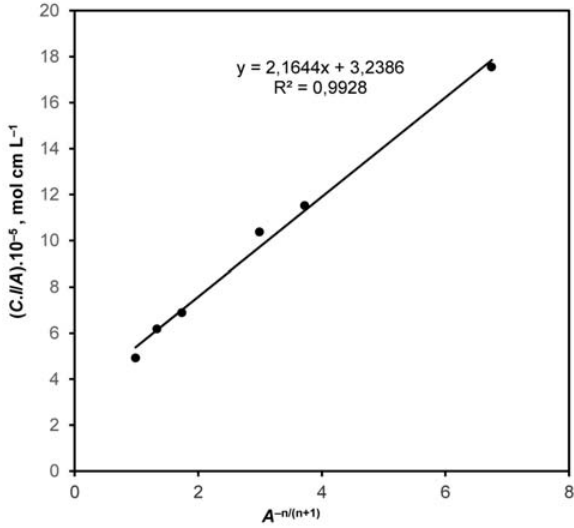
Figure 6. Dependency of ( C.l/A ) on A –n/(n+1) (method of Ko- mar–Tolmachev). C = C